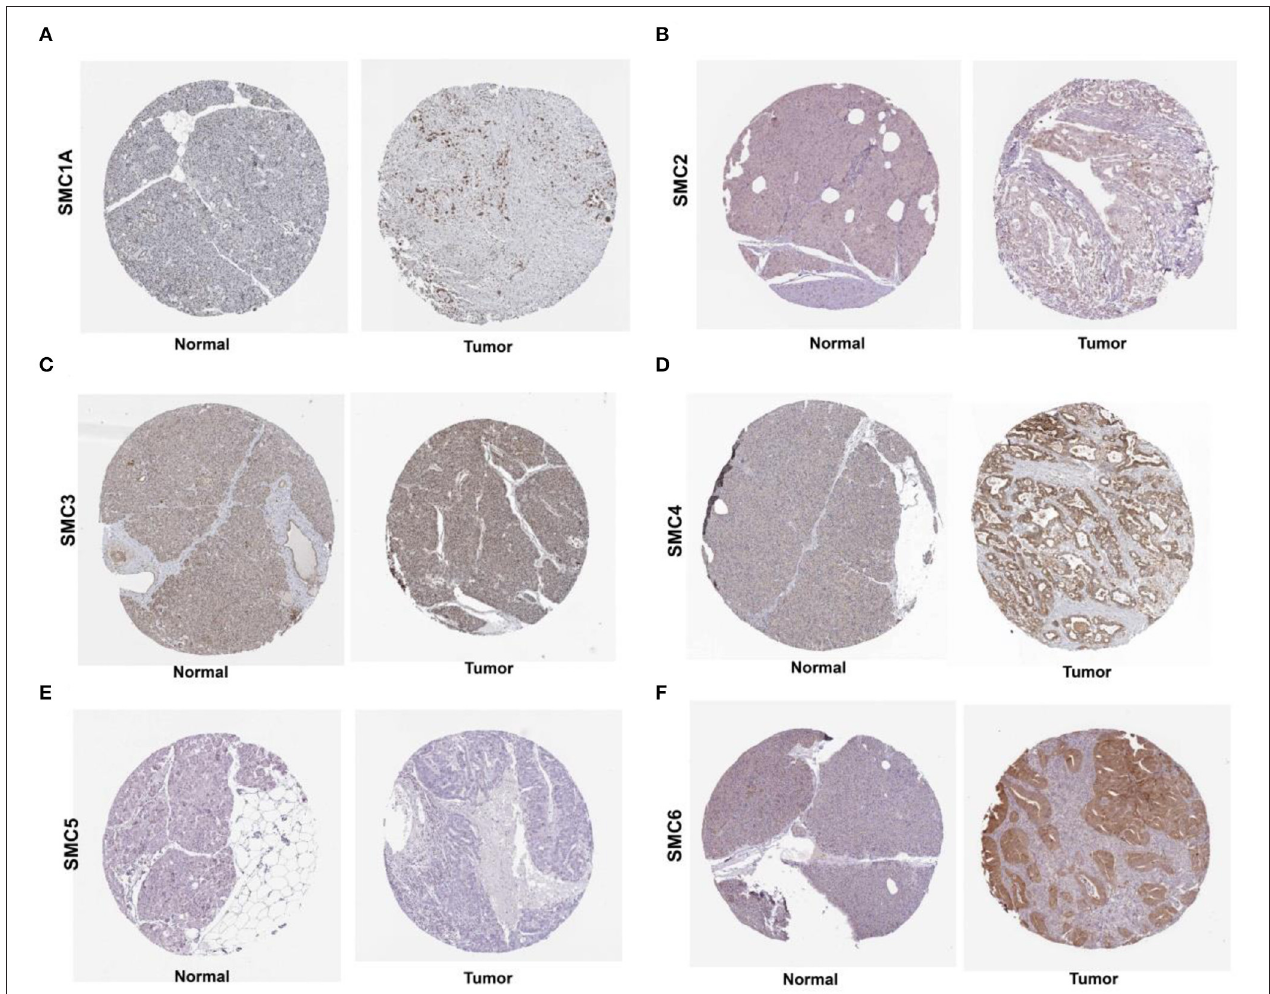
FIGURE 2 | Levels of SMC proteins expressed in PAAD tissues, as obtained from the Human Protein Atlas (HPA). (A–F) Protein levels of SMC1A, 2, 3, 4, 5 and 6 in PAAD tissues, compared with those in noncancerous tissues (Original magnification, 40 ×